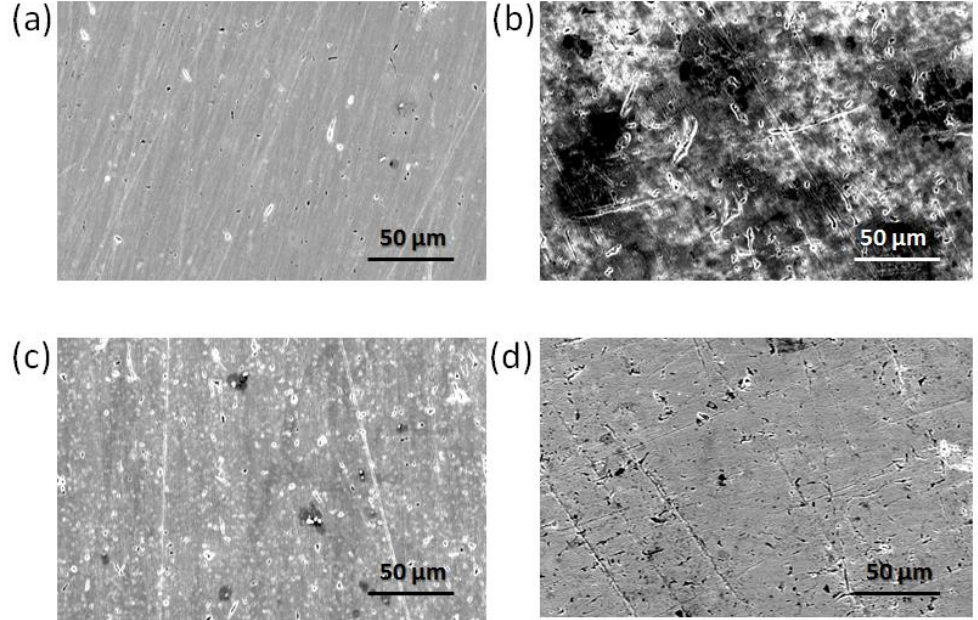
Figure 9. SEM images of EN3B mild steel ( a ) Polished ( b ) Immersed in 3.5% NaCl, pH = 1.5 without inhibitor ( c ) In the presence of 10 mM Py8 ( d ) In the presence of 10 mM Py12.